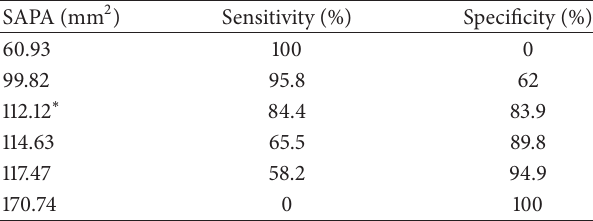
∗ The best cut-off point on the receiver operating characteristic curve. SAPA: superior articular process